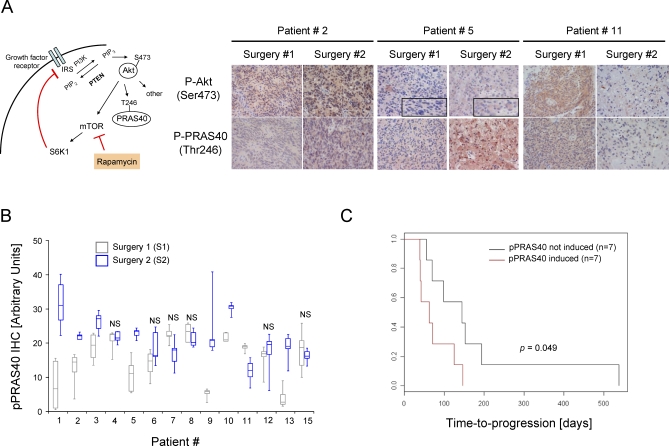
Induction of Akt Signaling in a Subset of Rapamycin-Treated Tumors(A) Determination of Akt activation in tumor tissue during mTOR inhibitor therapy. The left panel is a cartoon illustrating the mTOR/S6K1 dependent feedback loop of the PI3k-Akt pathway. The right panel shows changes in phosphorylation of the Akt-substrate PRAS40 (threonine 246) during rapamycin therapy correspond to changes in Akt phosphorylation (serine 473). Tumors from patients 2 and 5 show an increase in pAkt and pPRAS40 immunostaining during rapamycin treatment, whereas the tumor from patient 11 shows a decrease in the same markers on rapamycin.(B) Changes in PRAS40 phosphorylation between S1 and S2 for 14/15 rapamycin patients. The horizontal line inside the box indicates the median value. The lower and upper border of the box corresponds to the 25th and 75th percentile, respectively. The whiskers extend to the 95% range. Paraffin blocks from patient 14 were not sufficient for quantification. N.S. indicates that the difference in pPRAS40 staining intensity not statistically significant at the 0.05 level according to the Wilcoxon test.(C) Kaplan Meier analysis illustrating the relationship between pPRAS40 induction and time-to-tumor progression.